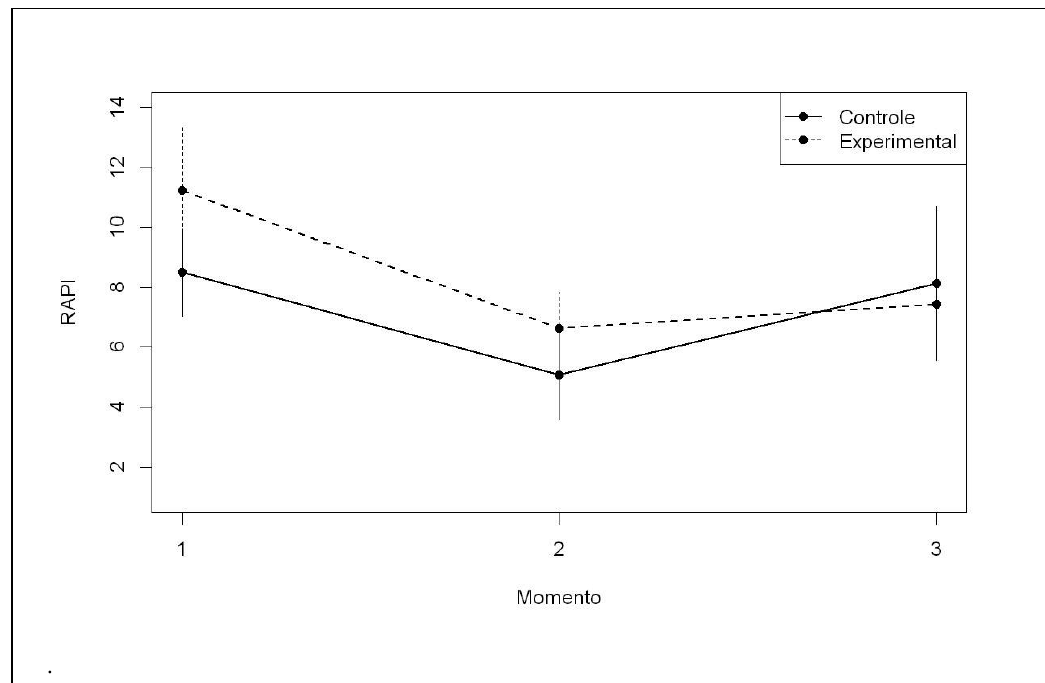
Figura 2 . Escore médio da variável RAPI de acordo com o grupo e o momento de avaliação.